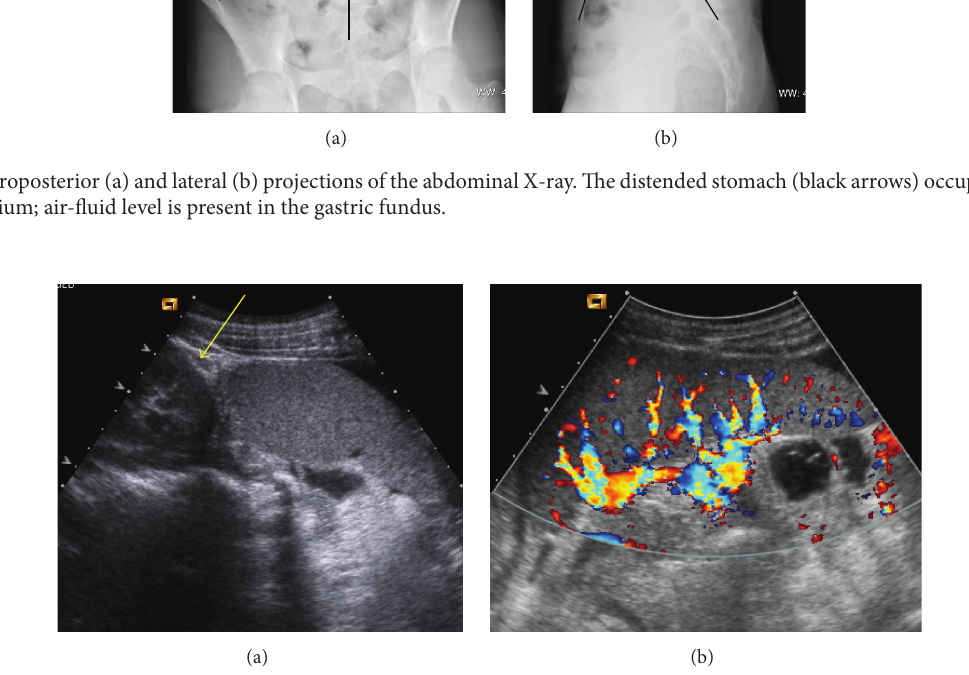
Figure 2: (a) Ultrasonography. The spleen is displaced caudal to the lower pole of the left kidney (yellow arrow). (b) Color Doppler ultrasound examination reveals a turbulent flow in splenic artery secondary to